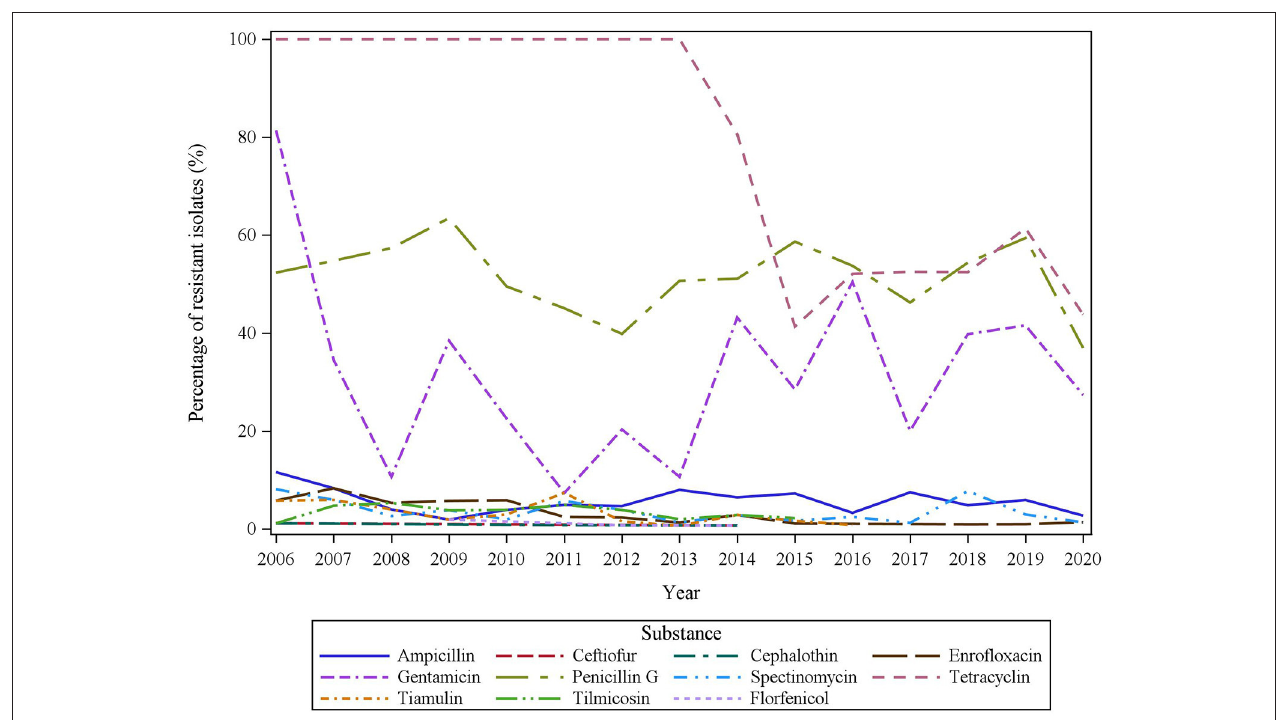
FIGURE 2 | Time dependent development of resistant isolates in the years from 2006 to 2020.